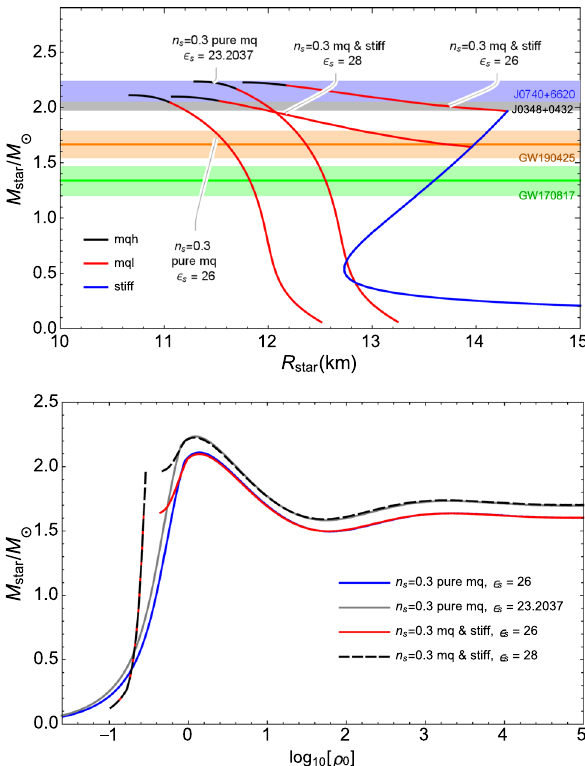
Fig. 4 MRdiagramandmass-centraldensityofNSandquarkstar.The colour label represents the corresponding nuclear phase at the center of the star. Each point corresponds to a star with mass profile consisting of subsequent layers of nuclear phases in order of high to low density: multiquark, polytrope (stiff), and CET. The pure hypothetical multi- quark star has only multiquark layers. Observational NS masses are also presented for